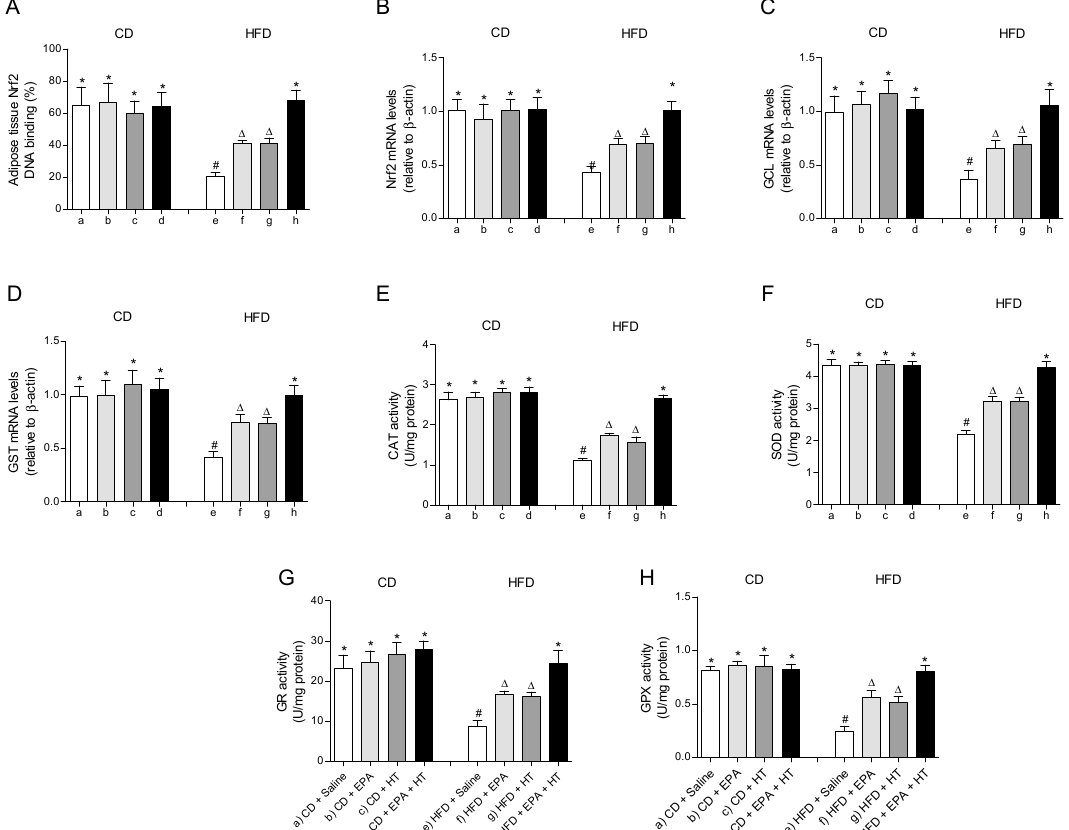
Figure 2. Nuclear factor E2-related factor 2 (Nrf2) DNA binding, ( A ) Nrf2 mRNA levels, ( B ) mRNA levels of glutamate-cysteine ligase (GCL) ( C ) and glutathione-S-transferase (GST), ( D ) and activity of catalase (CAT), ( E ) superoxide dismutase (SOD), ( F ) glutathione peroxidase (GPX), ( G ) and glutathione reductase (GR) ( H ) in epididymal white adipose tissue from mice subjected to control diet (CD) and high-fat diet (HFD) supplemented or not with eicosapentaenoic acid (EPA), hydroxytyrosol (HT) or EPA + HT. Values are expressed as mean ± SD. Eight to ten mice were included in each experimental group. Groups that do not share the same superscript symbol were significantly different among them, namely, (a), CD + saline; (b) CD + EPA; (c) CD + HT; (d) CD + EPA + HT; (e), HFD + saline; (f) HFD + EPA, (g) HFD + HT; and (h), HFD + EPA + HT, according to two-way analysis of variance (ANOVA) followed by the Tukey’s post-test, p < 0.05. ( * ), does not differ from (a) group; ( # ), differ from (a) group and does not differ from (e) group; ( ∆ ), differ from (a) and (b) groups.